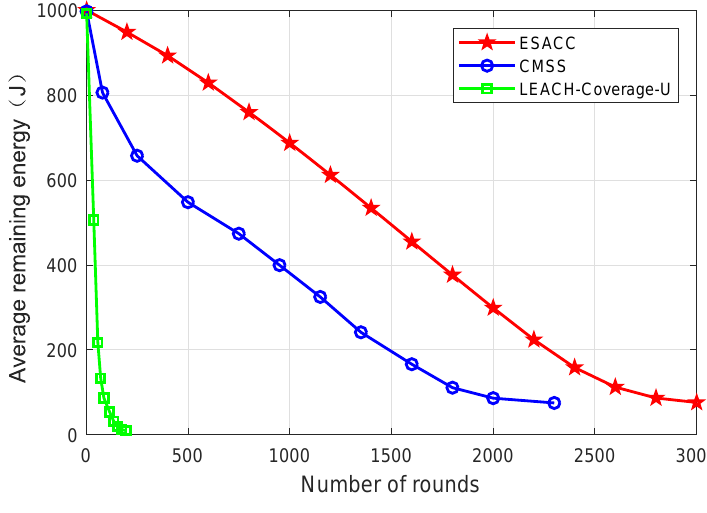
Figure 11. Average residual energy of network